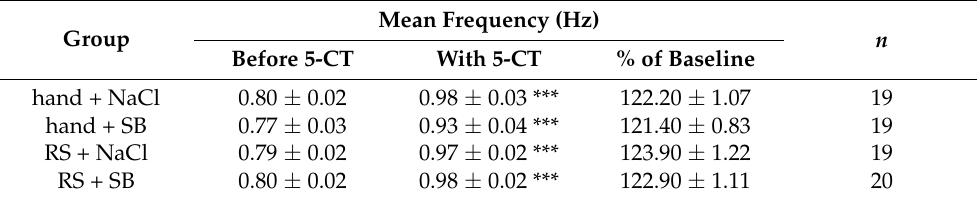
Table 8. Effects of 5-HT 7 receptor activation on parameters characterizing sIPSCs in DRN neurons from rats receiving restraint and SB 269970 (mean ±